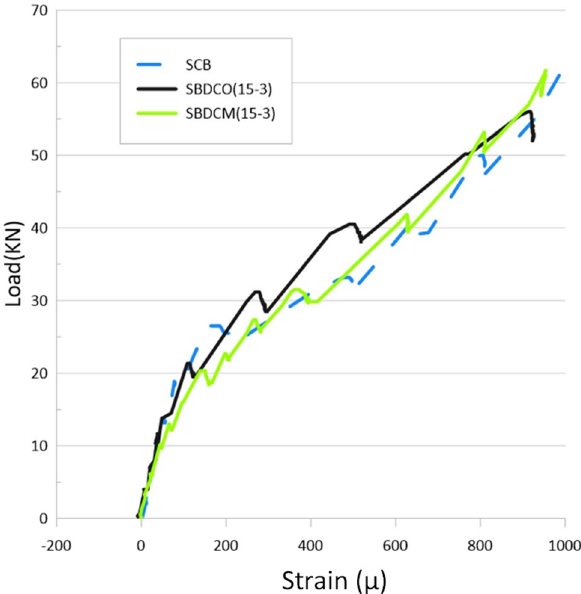
Fig. 16 Load–strain curves for two specimens compared to those of the control